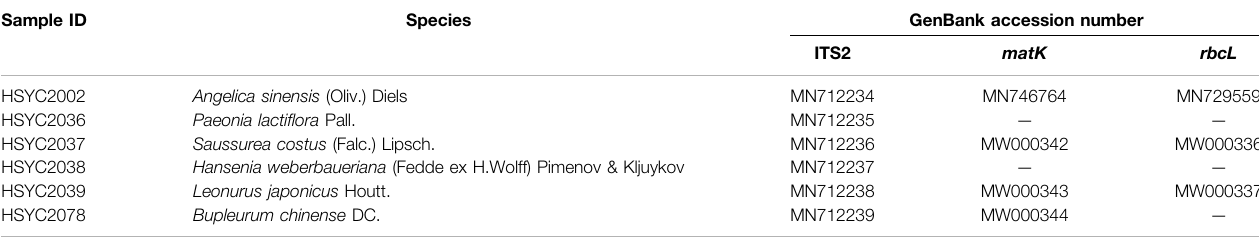
TABLE 2 | The species of herbal materials assigned by classic DNA barcoding and their GenBank accession numbers. Sample